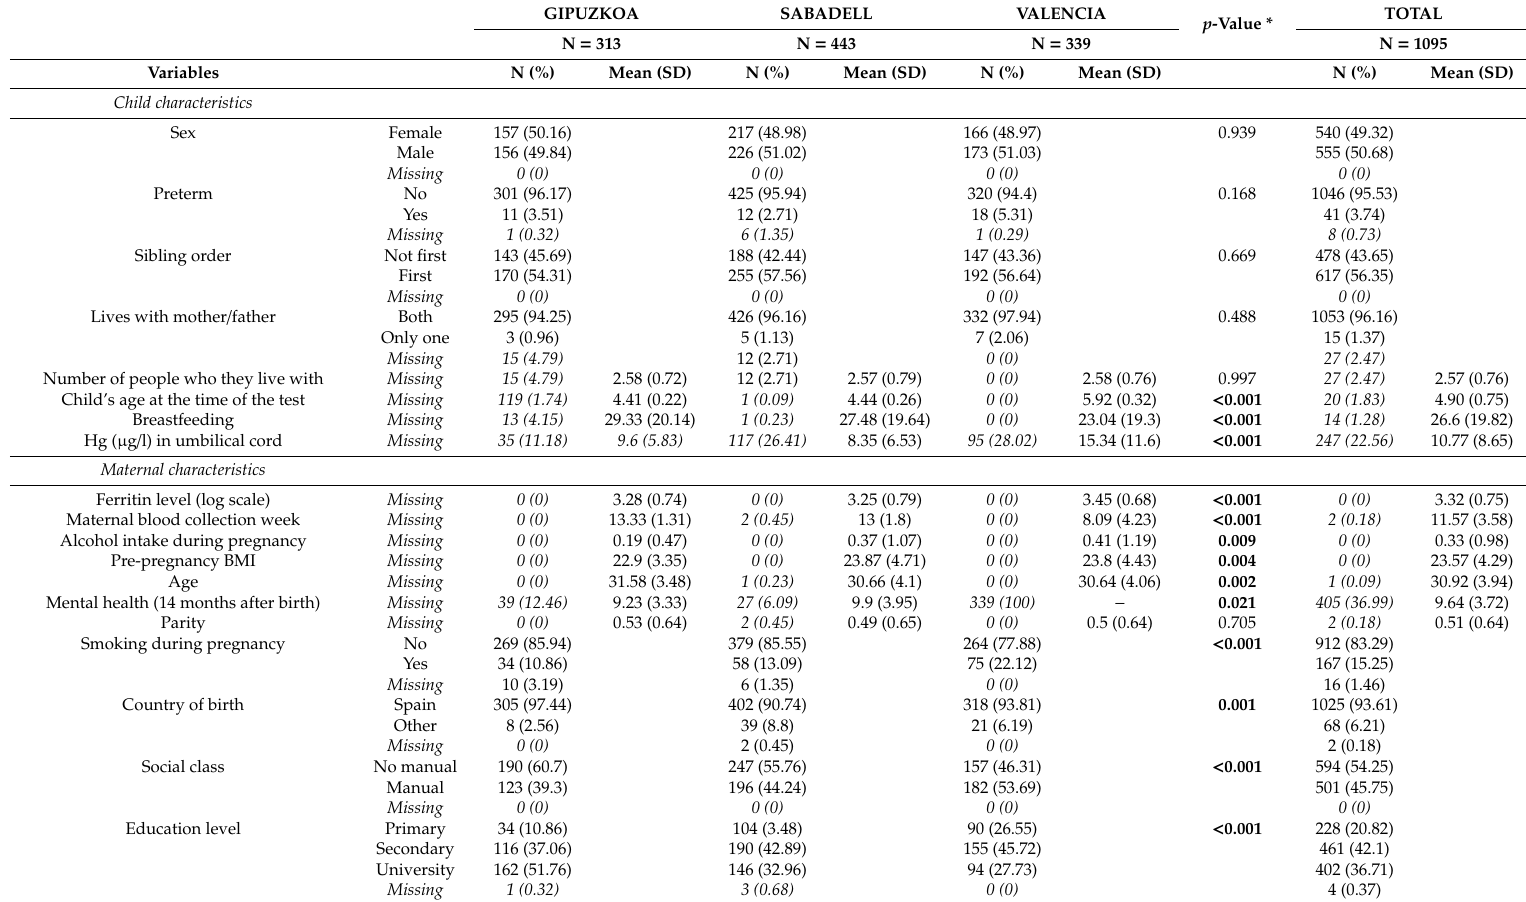
Table 1. Descriptive characteristics of the study